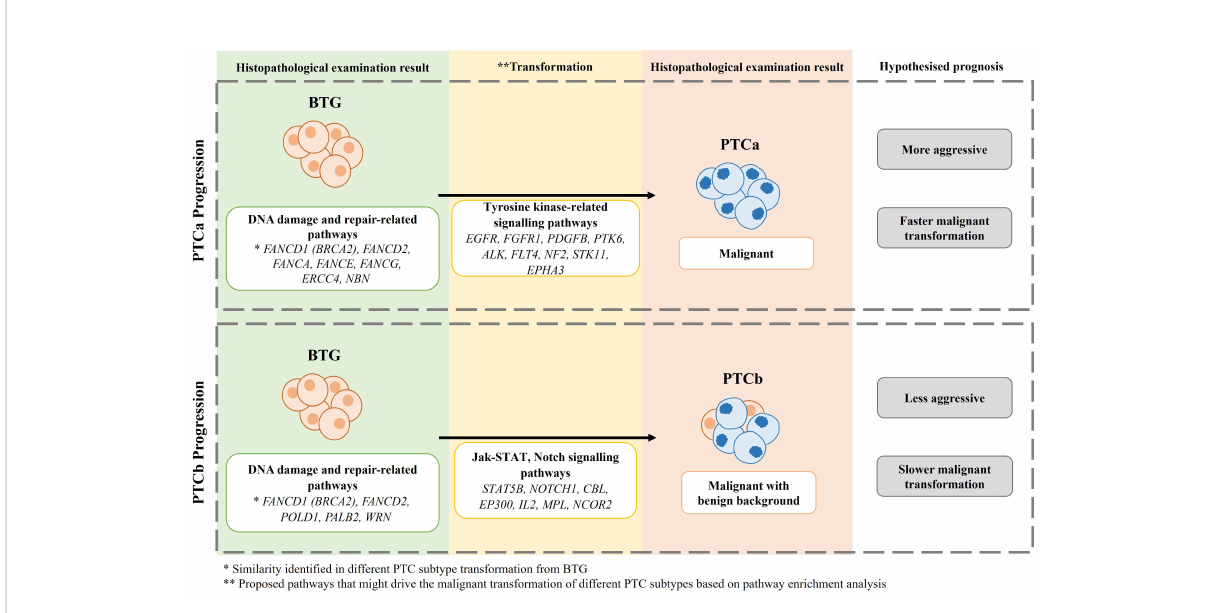
FIGURE 6 The proposed mechanism of BTG transformation to PTCa and PTCb in this cohort of